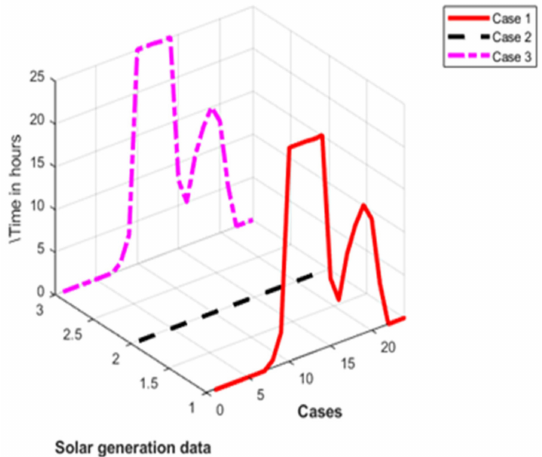
Figure 15. Solar generation data for three different cases with